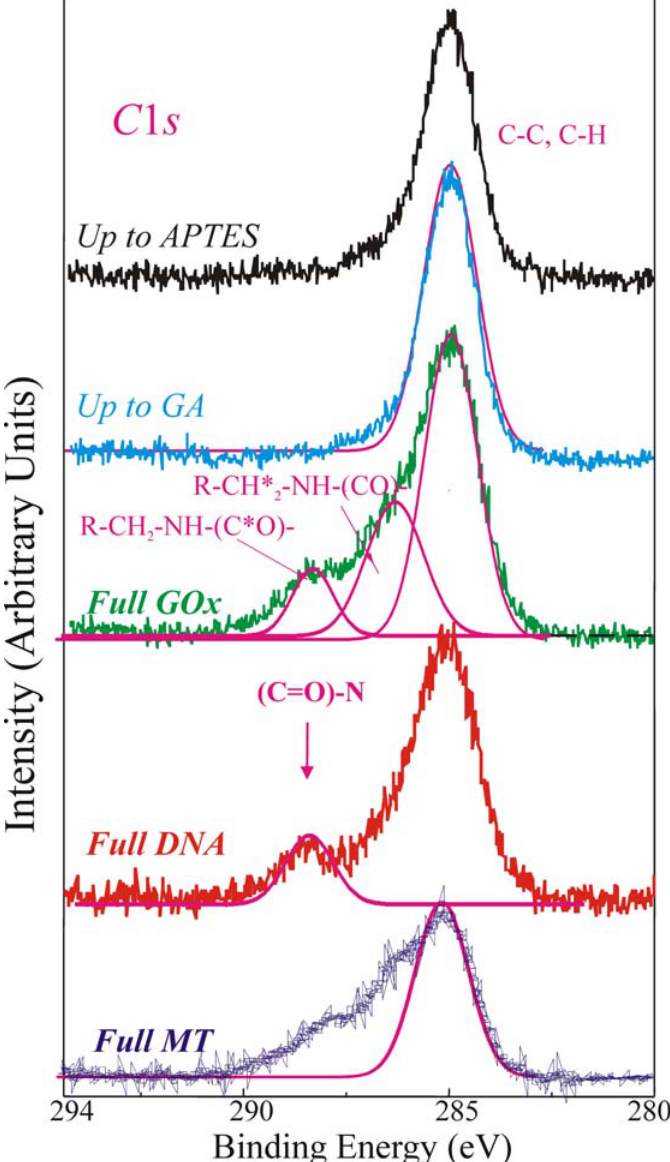
Figure 4. High statistic acquisition mode XPS C1 s spectral regions of: up-to-APTES (black line), up to GA (light blue line), fully processed with GOx (green line, Full GOx), fully processed with DNA (red line, Full DNA) and fully processed with MT (blue line, Full MT) samples. The magenta lines are the simulated